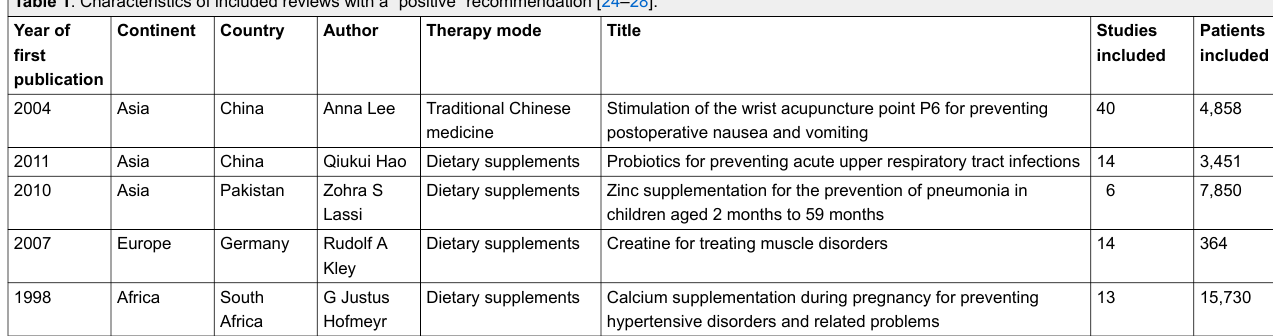
Table 1 : Characteristics of included reviews with a “positive” recommendation